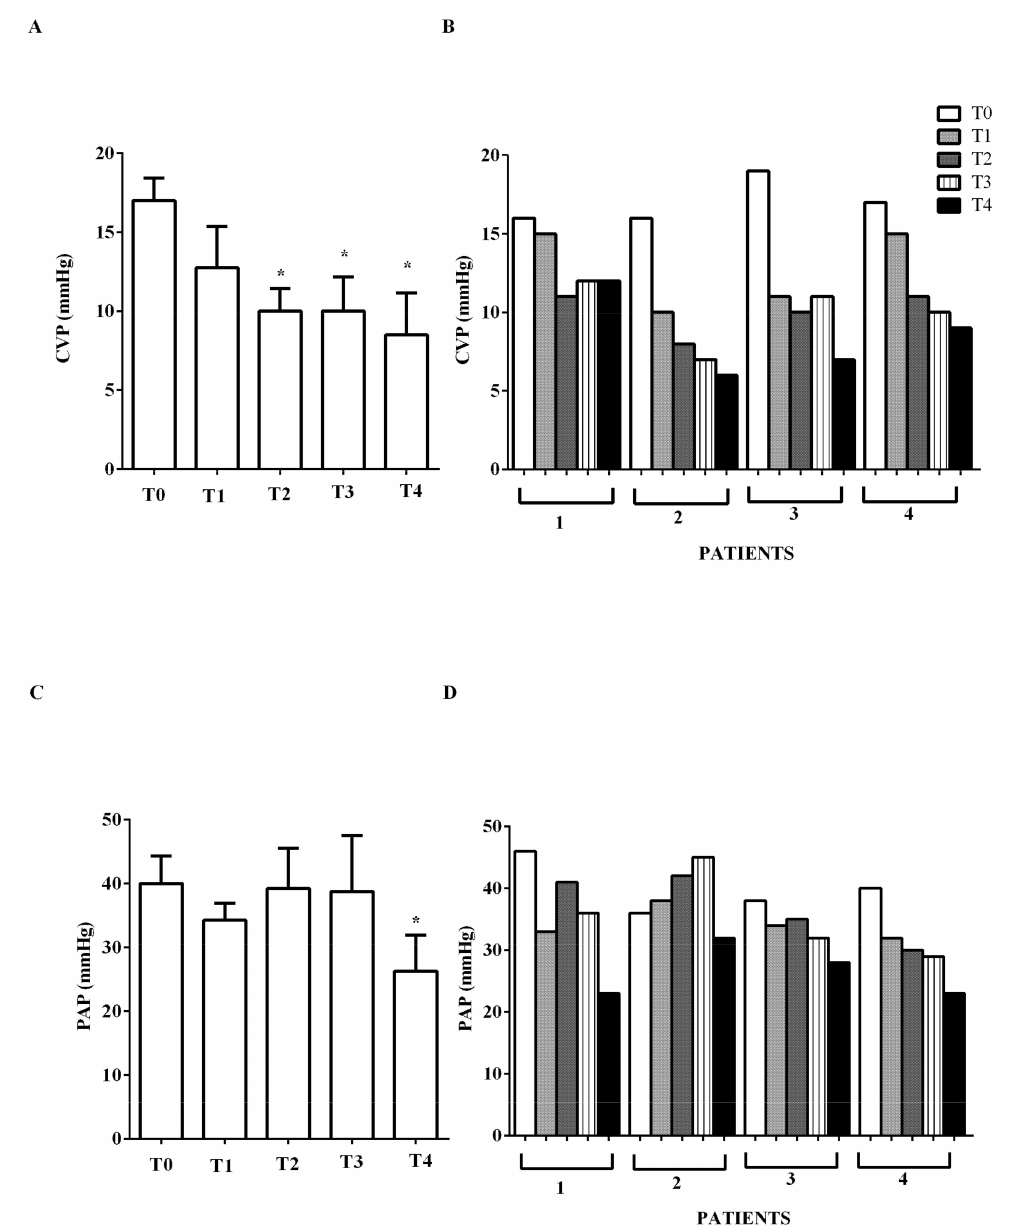
Figure 3. In ( A , B ), e ff ects of levosimendan on central venous pressure (CVP) and in ( C , D ) on mean pulmonary arterial pressure (PAP). In A and C, values are means ± SD. In B and D, columns represent single patients. * p < 0.05 vs.